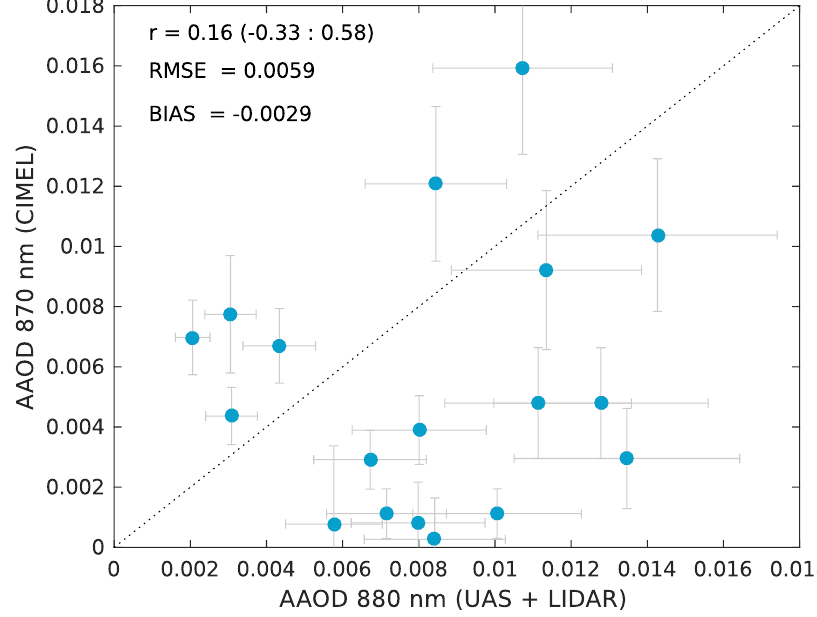
Figure 12. Comparison of the AAOD@870 nm obtained from the Level 1.5 AERONET data against AAOD@880 nm from UAS profiles extended with lidar observations during June–August 2015 at SolatAOT site (18 cases). Grey error bars show uncertainties. Dashed line (x = y) only for a